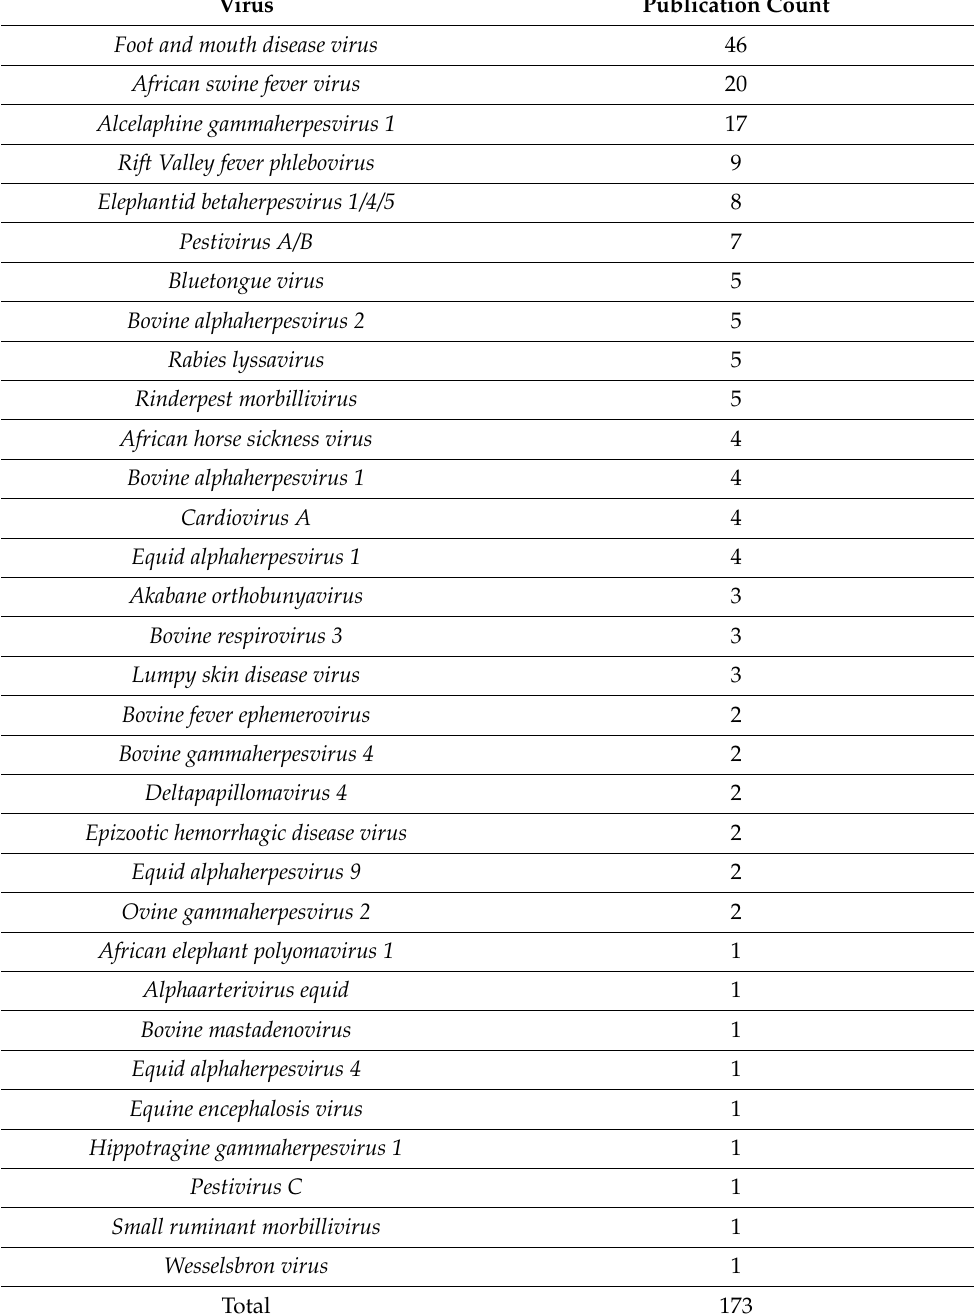
Table 2. Number of publications reporting on each virus in African